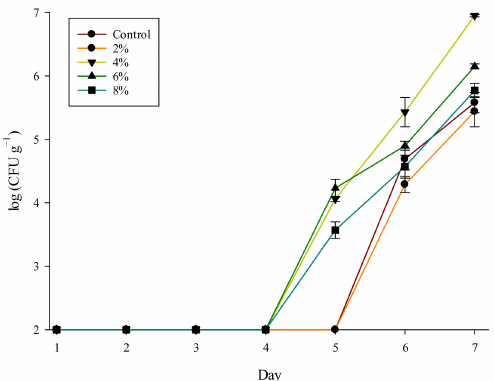
Figure 3. Effects of partially substituting high-gluten flour with soy protein isolate on the mold and yeast growth in